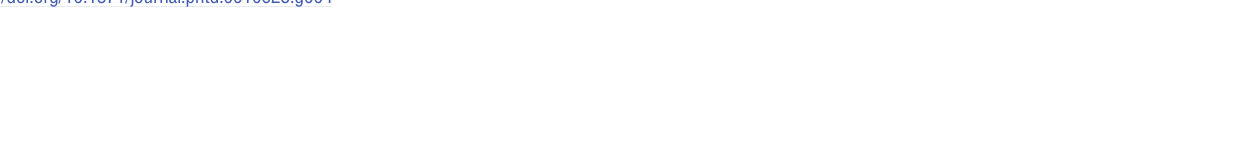
PLOS NeglectedTropical Diseases | https://doi.org/10.1371/journal.pntd.0010628 September 13,